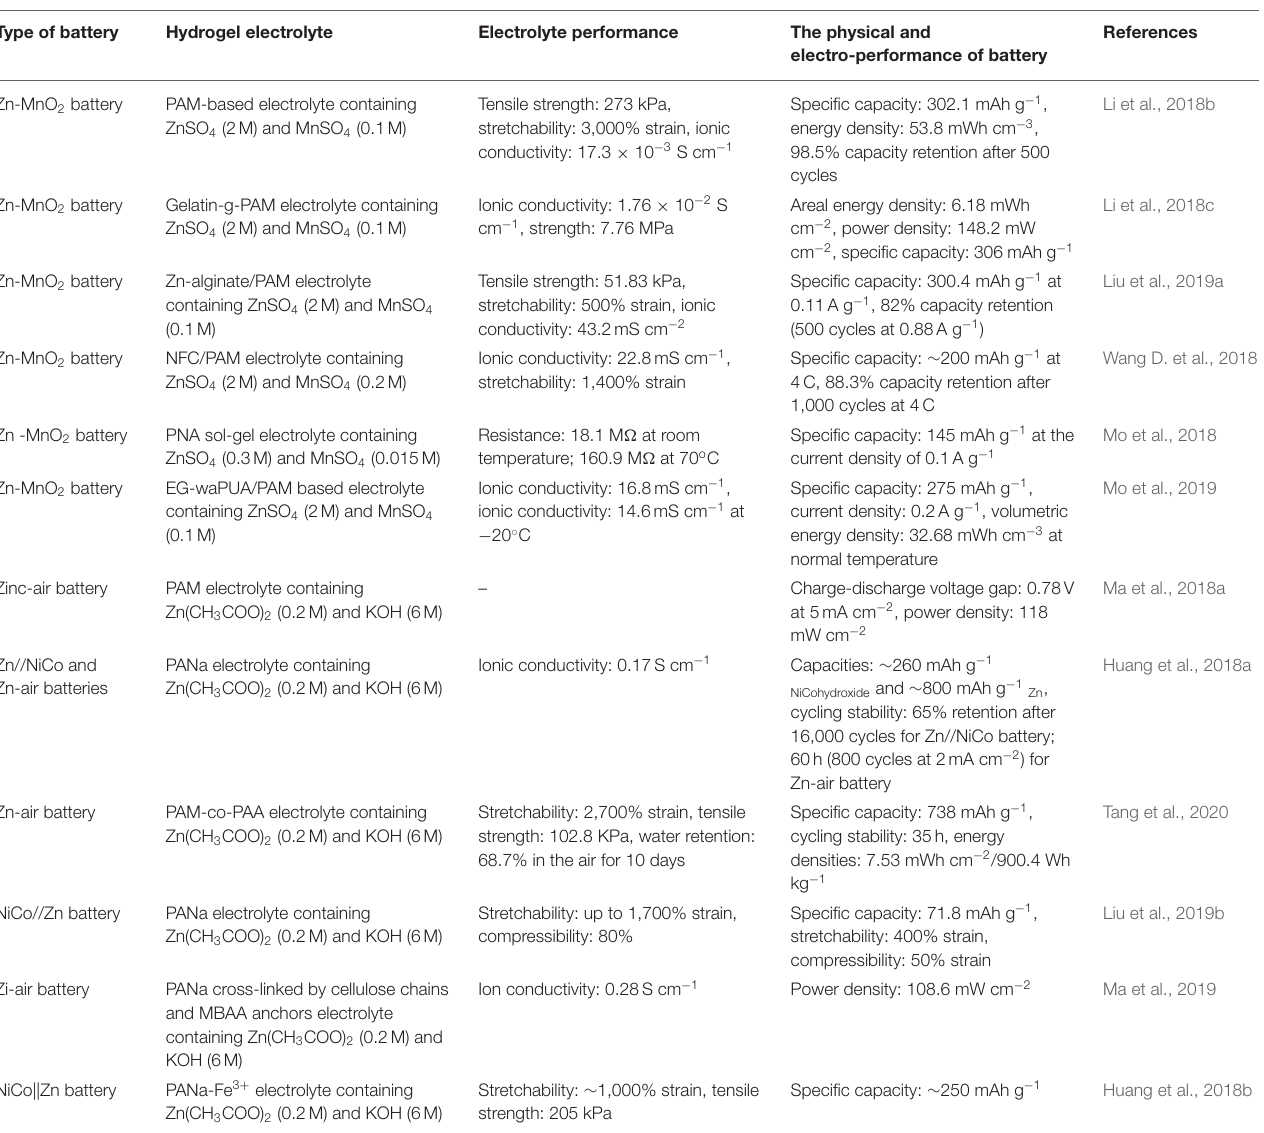
TABLE 1 | Comparison of functional zinc-based battery. Type of